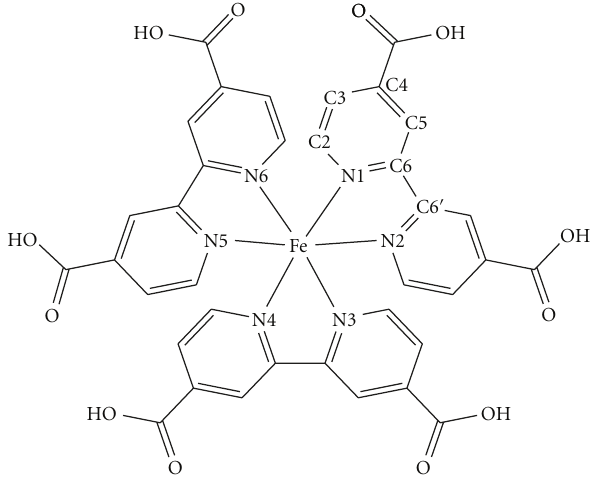
Figure 1: Sketch of chemical structures of the [FeL 3 ] 2+ complex (L = 2,2 (cid:2) -bipyridyl-4,4 (cid:2) -dicarboxylic acid) with the atom numbering